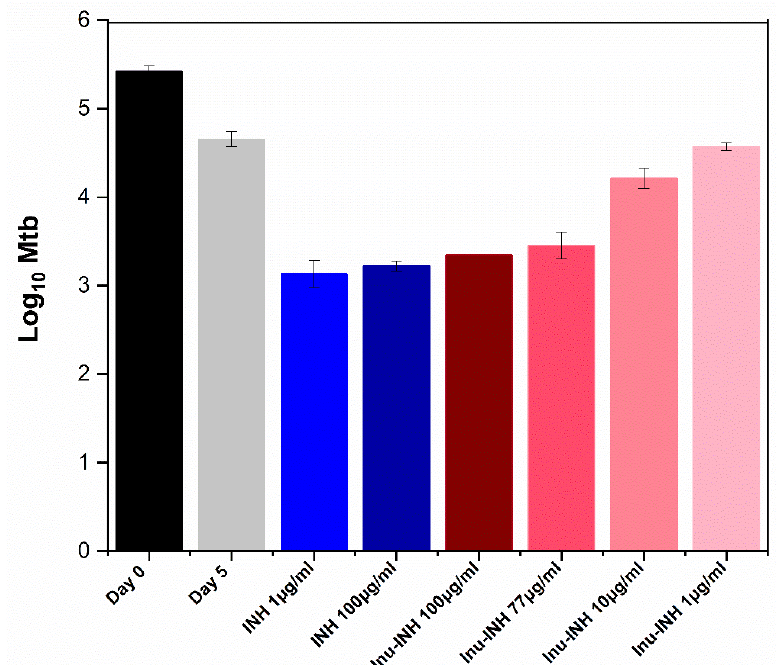
Figure 9. Intracellular antibacterial efficacy of pure INH and the inulin-INH conjugate suspension against Mycobacterium tuberculosis (Mtb) (C). Each log change represents a 10-fold difference in bacterial number. Day 0 is when the inulin-INH conjugate and soluble INH were added to the infected Mtb macrophages. Day 5 represents the cumulative drug effects after 5 days incubation.